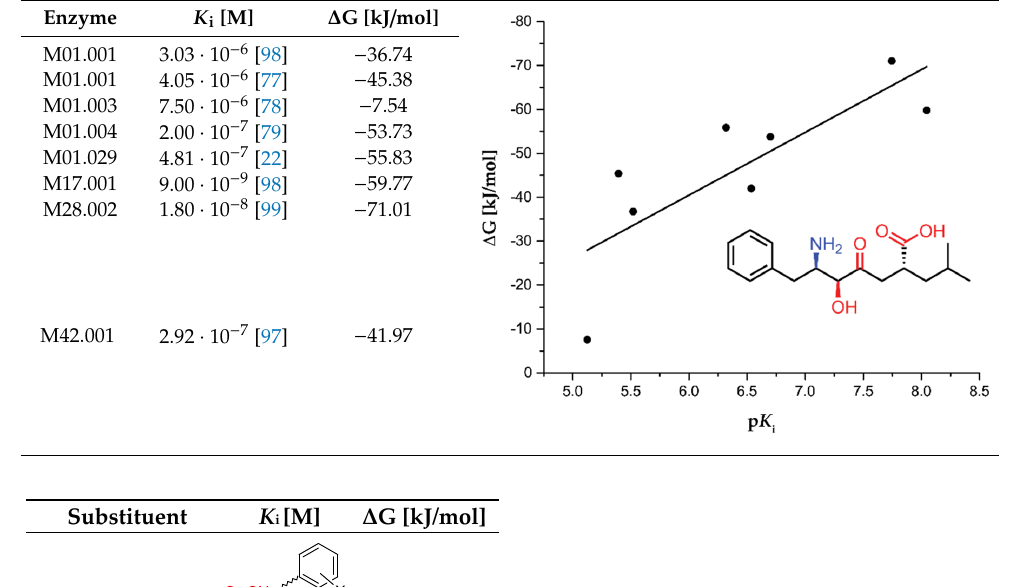
Table 9. Correlation plot of inhibitory activity of bestatin (p K i ) reported for different metallo- aminopeptidases with the corresponding values of the calculated free Gibbs energy (R 2 = 0.65).